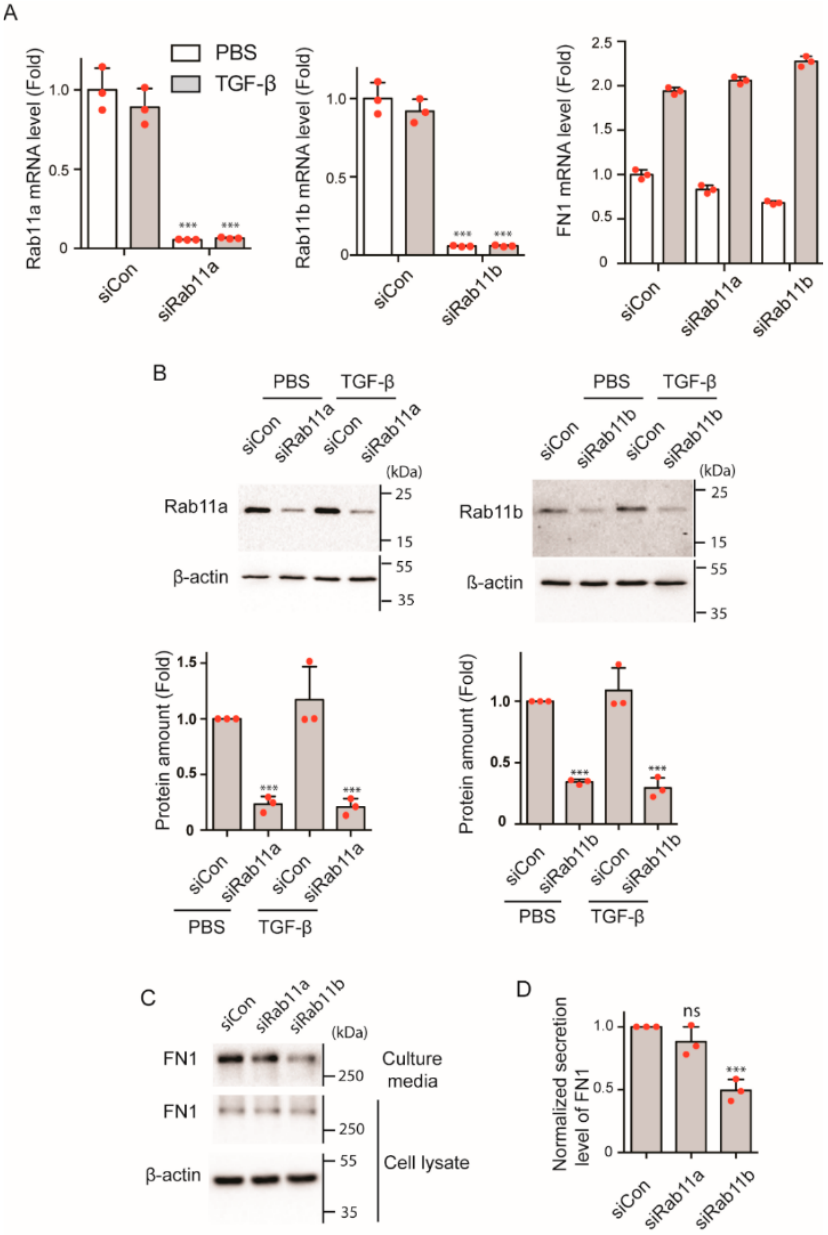
Figure 6. Effect of gene silencing of Rab11a and Rab11b, respectively on FN1 secretion. ( A ) Effect of gene silencing of Rab11 isoforms on mRNA level of Rab11 isoforms and FN1 by specific siRNAs. mRNA expression was examined by qPCR analysis. siCON, control siRNA; siRab11a, Rab11a specific siRNA; siRab11b, Rab11b specific siRNA. *** p < 0.001 vs. siCon. ns, not significant ( n = 3, mean ± SD). ( B ) Effect of Rab11 gene silencing on Rab11 protein expression level in cell lysate. Top, representative Western blot; Bottom, statistical representation of the Western blot signal ( n = 3, mean ± SD). *** p < 0.001 vs. siCon. Full-length blots were presented in Supplementary Figure S3. ( C ) Effect of Rab11 isoform KD on FN1 secretion. Representative image of Western blot analysis of FN1 protein amount in cell lysate and culture media. Control siRNA and Rab11a or Rab11b specific siRNA transfected HPMCs were serum starved for 16 h and cells were then treated as described in the legend for Figure 5. Full-length blots were presented in Supplementary Figure S3. ( D ) Statistical representation of normalized secreted level of FN1 after TGF- β stimulation ( n = 3, mean ± SD). *** p < 0.001. ns, not significant. The red spots in bar graphs display the distribution of data